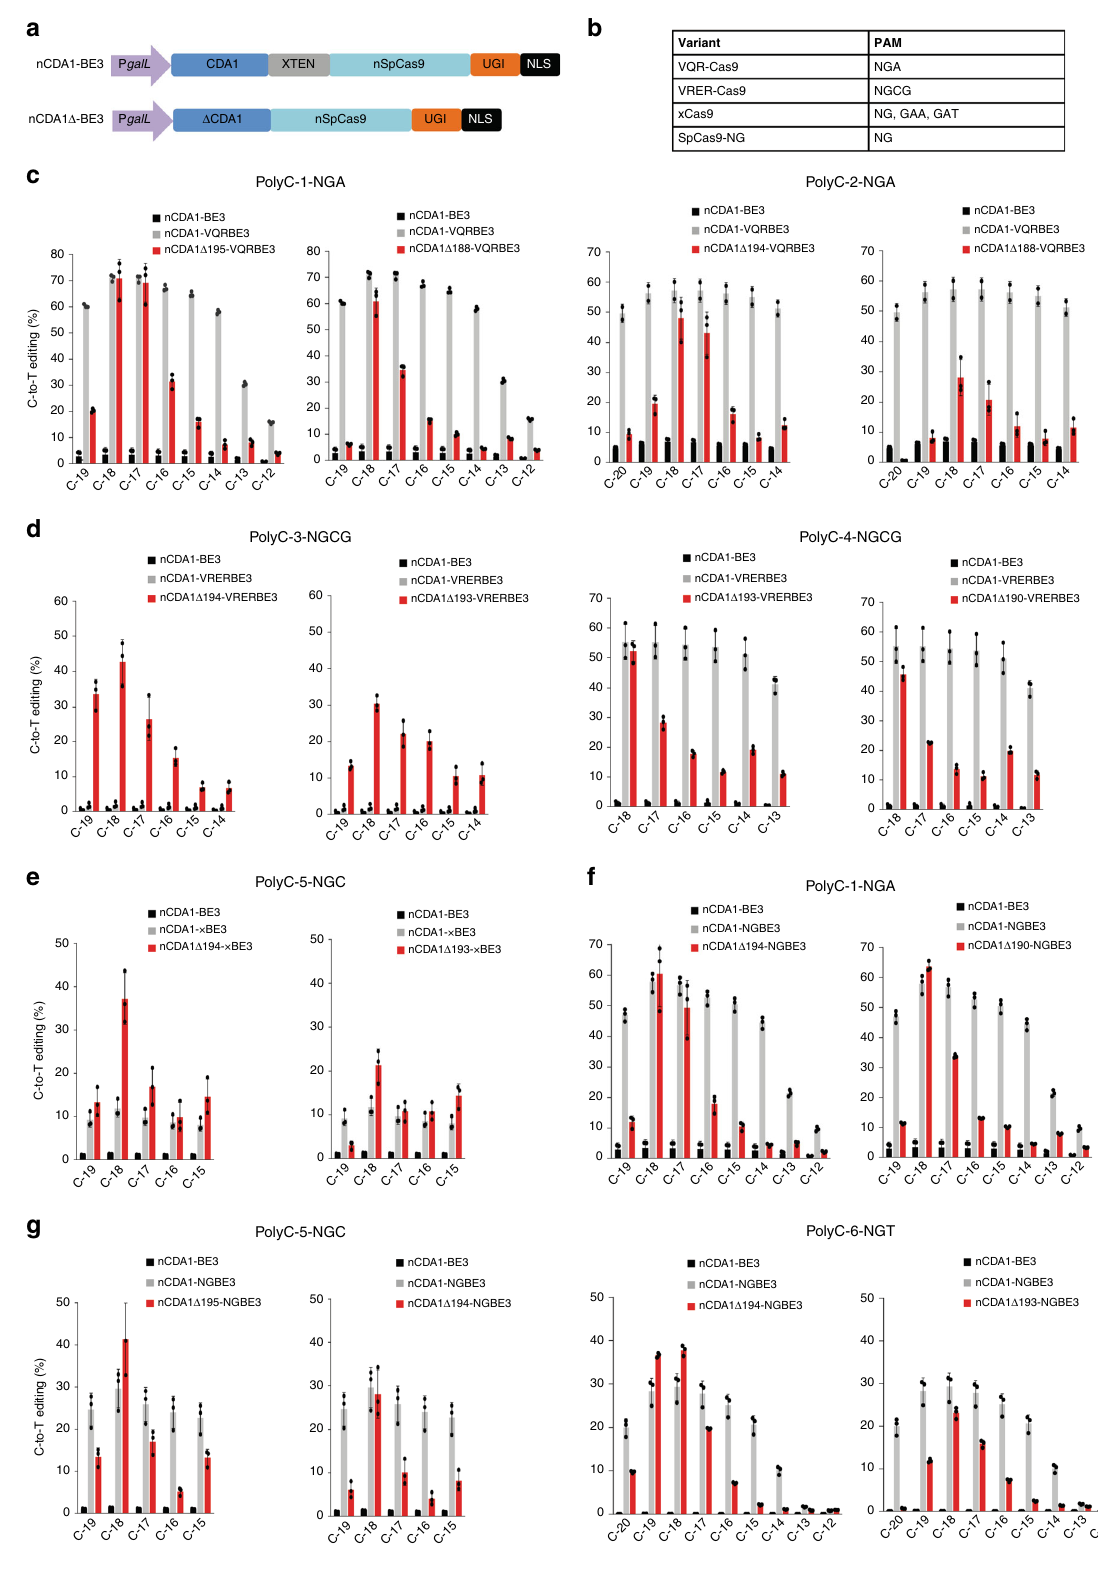
the PAM (Supplementary Fig. 1). The activity window ranged from C − 14 to C − 19 in target sequence PolyC-1-NGA and from C − 14 to C − 20 in target sequence PolyC-2-NGA. By contrast, VQR-Cas9 BEs harboring CDA1 truncations had a much narrower activity window and predominantly edited positions C − 17 and C − 18 in target